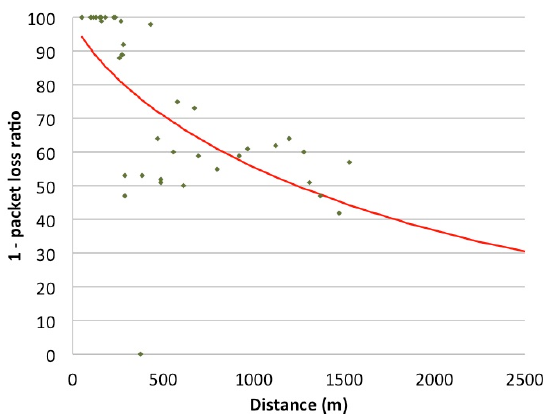
Figure 1. The relation between the distance to the destination and packet losses.